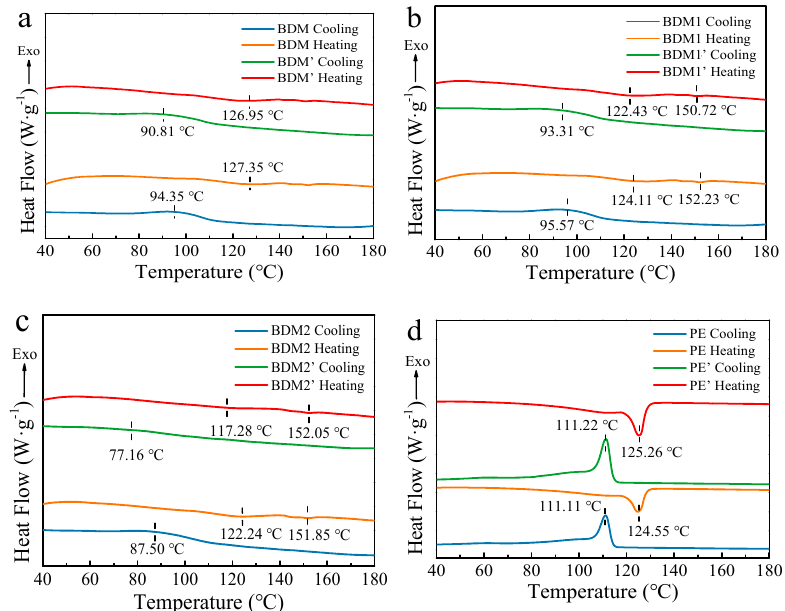
Figure 4. DSC cooling and heating curves of BDM and BDM ′ ( a ), BDM1 and BDM1 ′ ( b ), BDM2 and BDM2 ′ ( c ), PE and PE ′ ( d ). BDM2 (cid:48) ( c ), PE and PE (cid:48) ( d ).